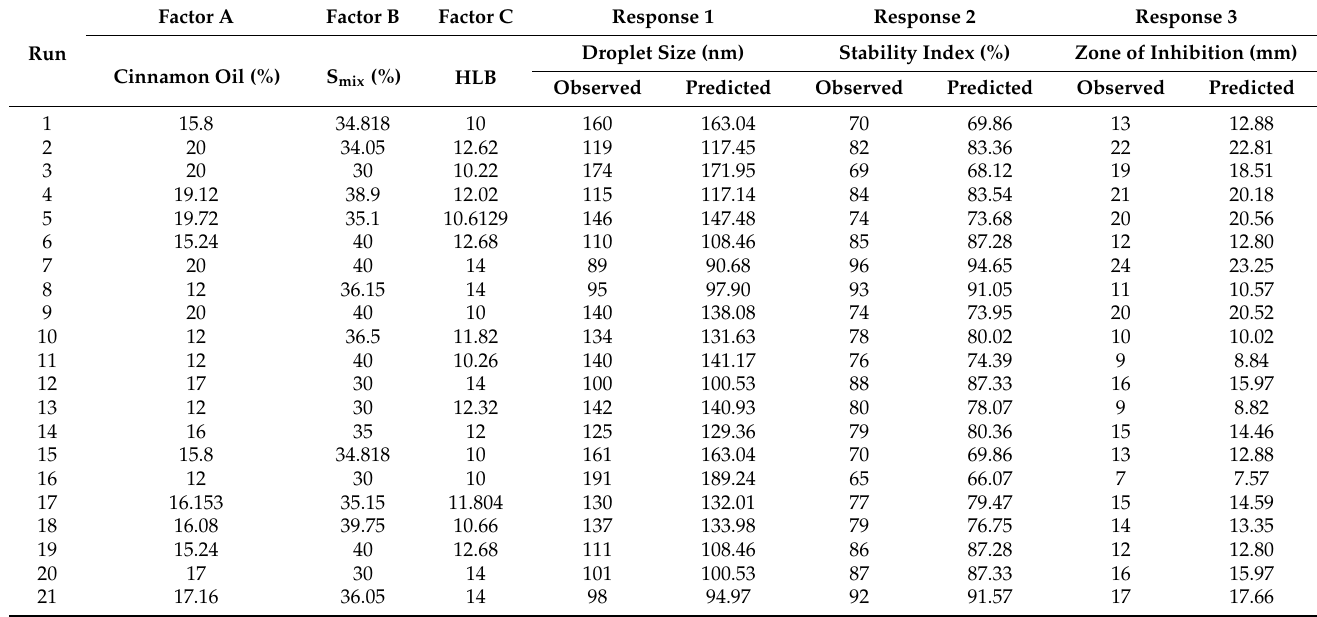
Table 3. The independent factors and responses for the design of